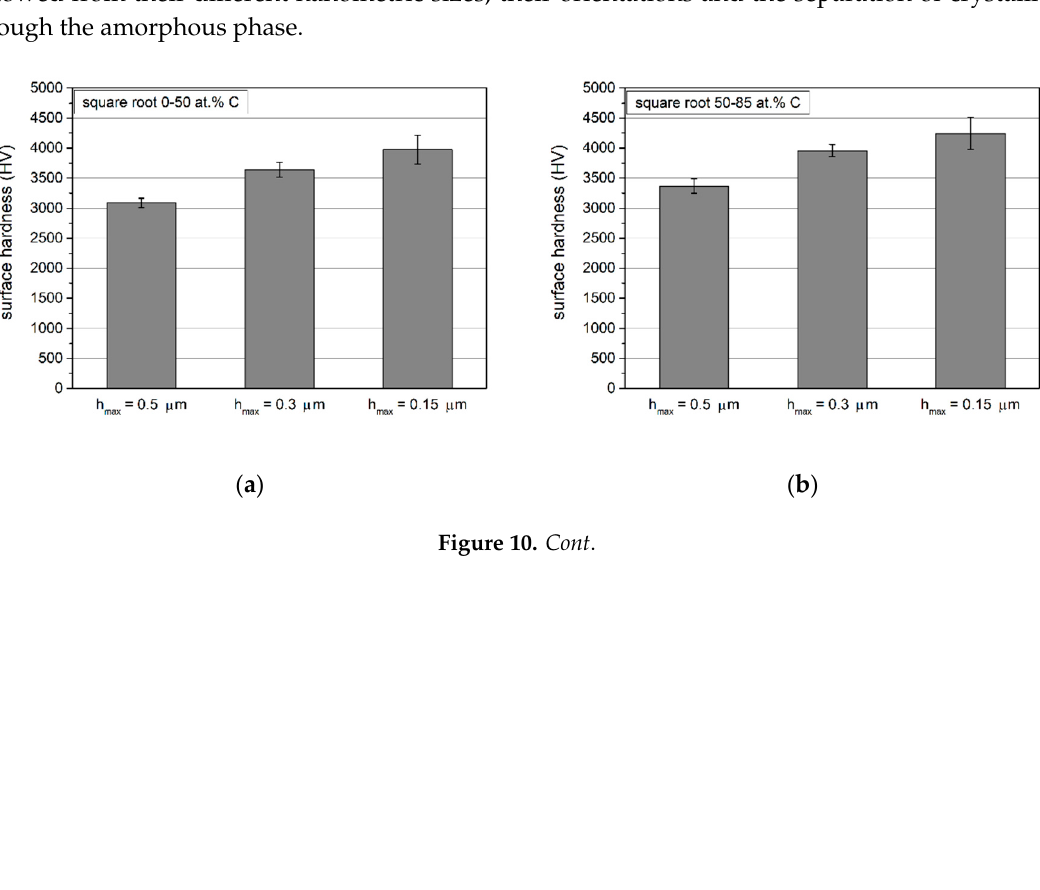
Figure 10. Surface hardness of coatings with three different maximum loads causing indentations of 0.15, 0.30 and 0.5 μ m: ( a ) square root carbon content variation profile in the range of 0–50 at.%, ( b ) square root carbon content profile in the range of 50 to 85 at.%, ( c ) parabolic carbon content profile in the range of 0–50 at.%, ( d ) parabolic carbon content profile in the range of 50 to 85 at.%. 3.4.3. Evaluation of Coating Adhesion Using the Scratch Test In accordance with the methodology presented in Section 2.5, the so-called scratch test was carried out on all of the gradient coatings produced and, for the purpose of comparison, on coatings with a determined and fixed carbon concentration. The determined values of critical loads L c1 and L c2 are presented in Figure 11a, and the dependence of friction force from normal force is presented in Figure 11b (for gradient coatings) and in Figure 11c (for selected single-layer coatings with fixed carbon content). The results obtained demonstrated that the values of critical forces L c1 of all of the gradient coatings tested, which proved the occurrence of cohesion damage, were more than twice as high as the values of these forces for single-layer coatings. The tests presented also demonstrated that the coating with the square root profile (k = 0.5), in the concentration range of 50–85 at.%, is characterized by the highest adhesion, determined on the basis of critical load L C2 . The comparison of the values of the Lc 2 critical forces for coatings in the range of 0–50 and 50– 85 at.% of C with the square root hardness profile showed that, regardless of the hardness, the nano/microstructure had a significant impact on the adhesion of the coatings, as also demonstrated by other authors [28–33]. On the other hand, the reason for the higher value of the critical force Lc 2 for a coating with an square root hardness profile compared to a coating with a parabolic profile, in the case of coatings in the range 50–85 at.% of C, may be higher changes in hardness in the area adjacent to the substrate/coating interface for the first of the mentioned coatings (Figure